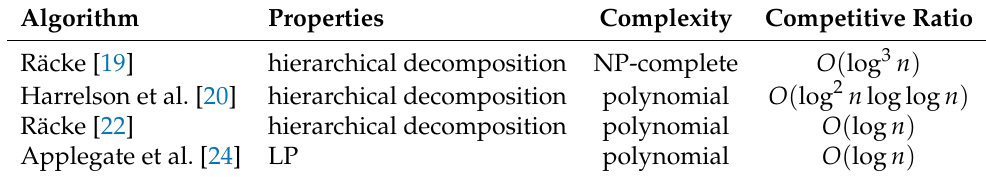
Table 1. A summary of oblivious routing